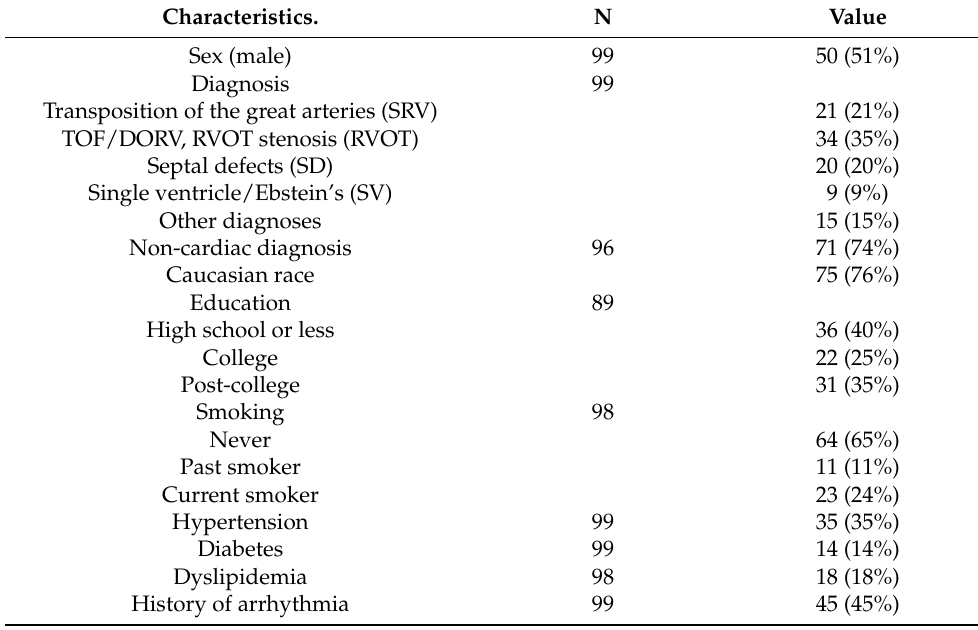
Table 1. Patient characteristics (N = 99).